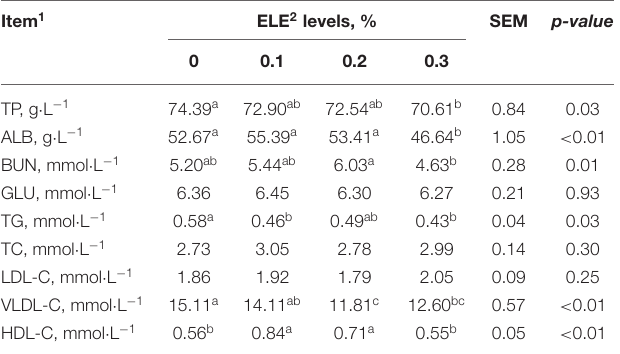
TABLE 5 | Effects of dietary ELE on serum biochemical indexes of growing–finishing pigs.